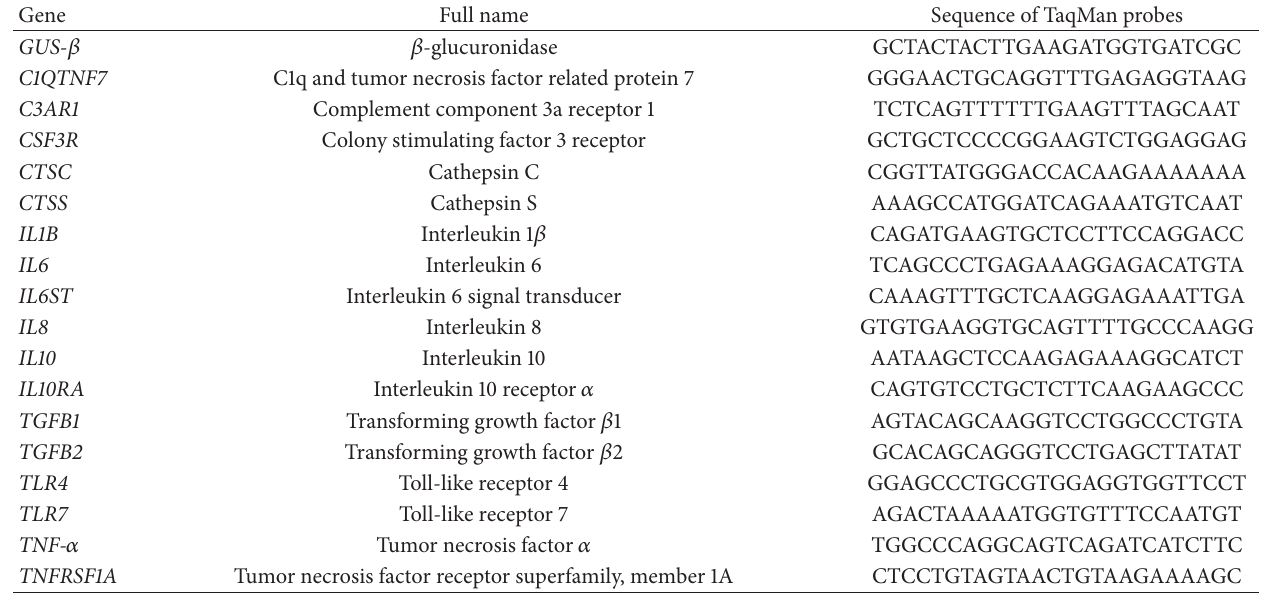
Table 2: Abbreviation of genes examined and full names and sequences of TaqMan probes used in the present